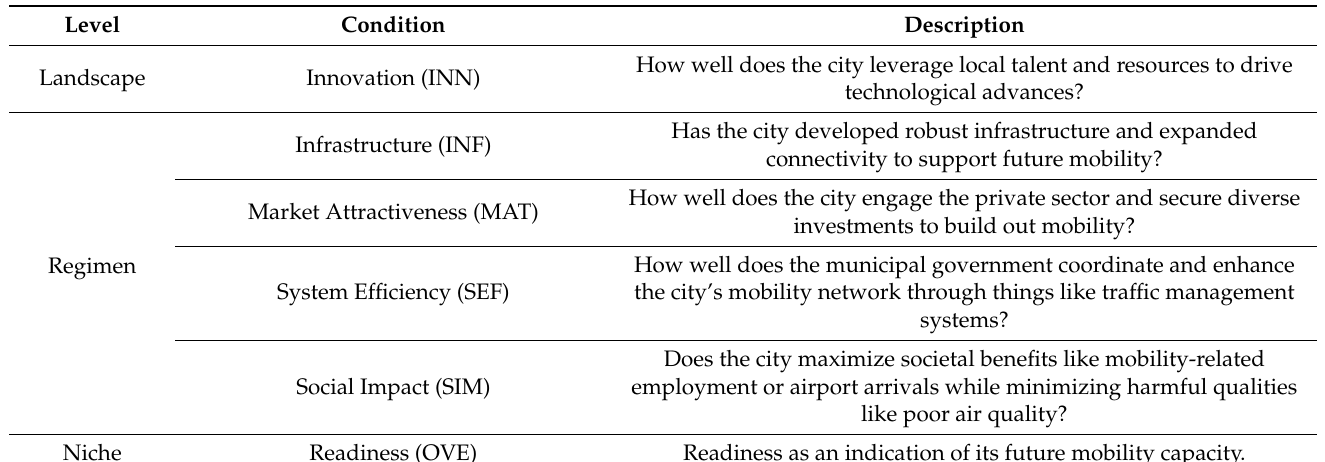
Table 2. Level and conditions